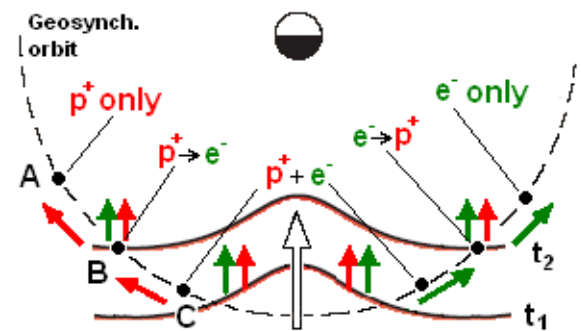
Fig. 5. Schematic of two snapshots of a double-spiral formation of the pulse front. The twin red-green arrows denote electrons and ions that propagate at the front of the pulse without dispersion. The single red (green) arrows denote ions (electrons) that drift out of the zero-grad-B region. Virtual geosynchronous satellites A, B and C will observe ion injections only, ion injections followed by delayed electron injection (p + → e − ) , and simultaneous ion and electron in- jections (p + +e − ) ,